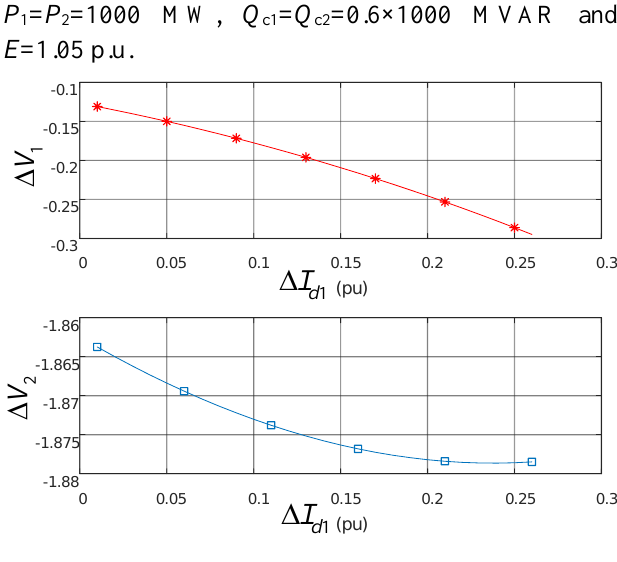
Fig. 5. Behavior of Δ V 1 , 2 vs Δ I d1 The change in bus voltage of nearby converter in close electric proximity is also occurred due to reactive power flow. If I of inverter 1 is increased, I d1 lack of reactive power at bus 1 cause reactive power to flow from bus 2 to 1 consequently Vbus2